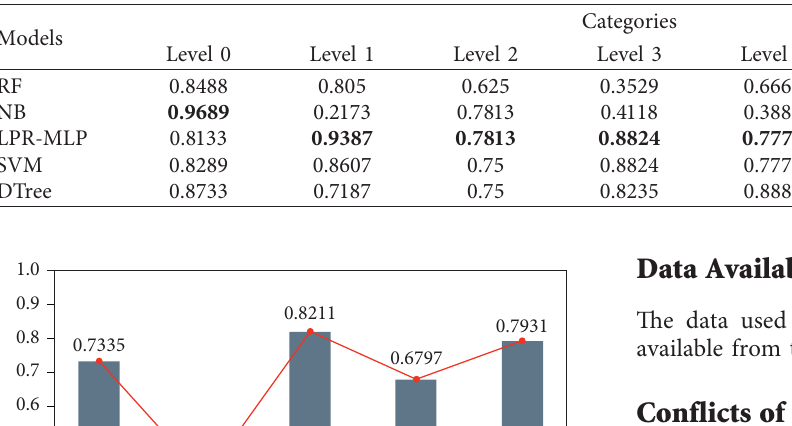
Table 5: Recall of all models.